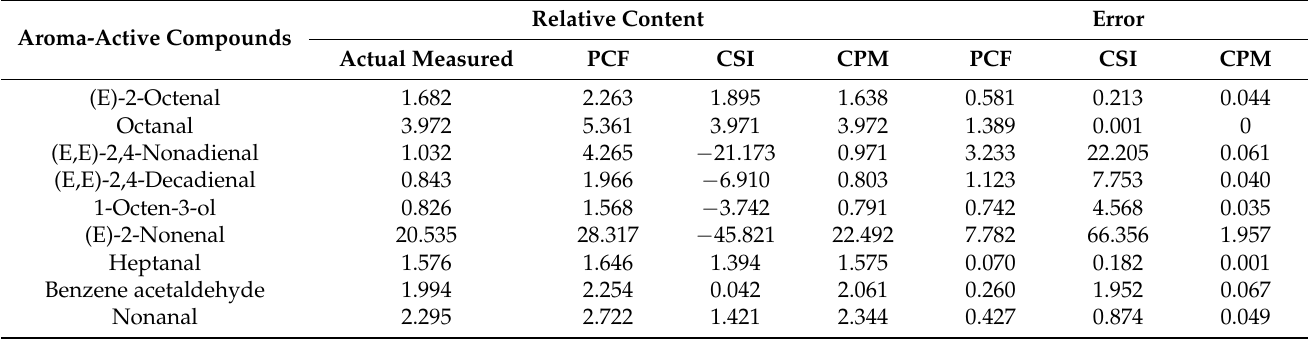
Table 4. Prediction error of three proxy models in verification experiment.